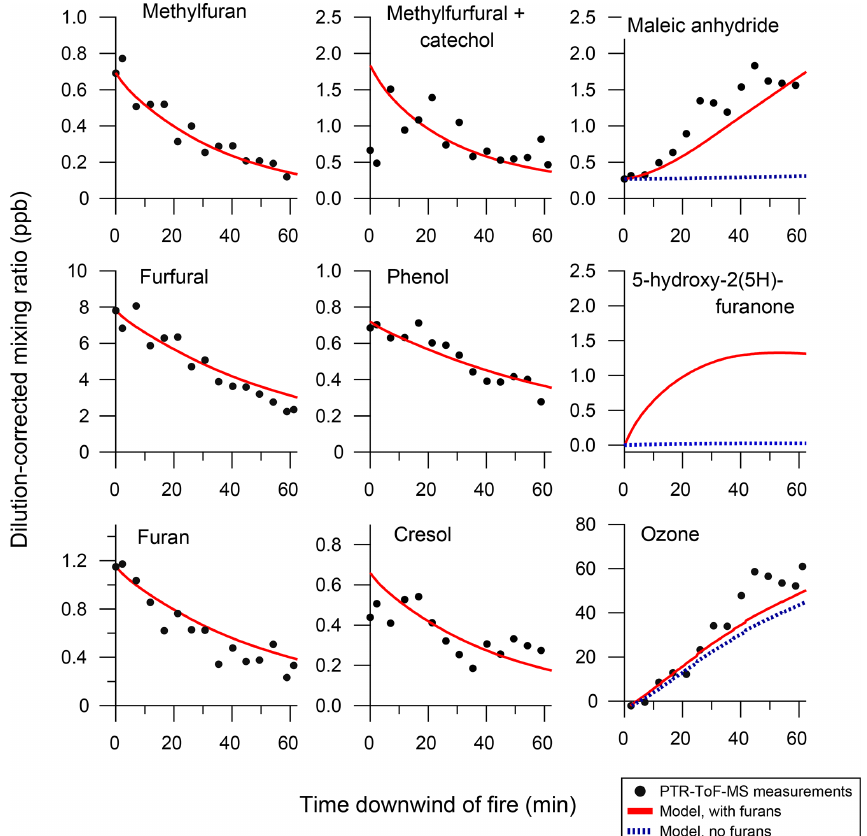
Figure 10. Summary of model results for the understory fire described by Müller et al. (2016). Data are presented as mixing ratios corrected for dilution (calculated based on the decay of CO). The initial conditions for methylfurfural + catechol and cresol were adjusted to best match the observed decay. Results with furans excluded from the model are shown as dotted lines. Maleic anhydride and ozone are shown to illustrate the impact of furans on secondary product